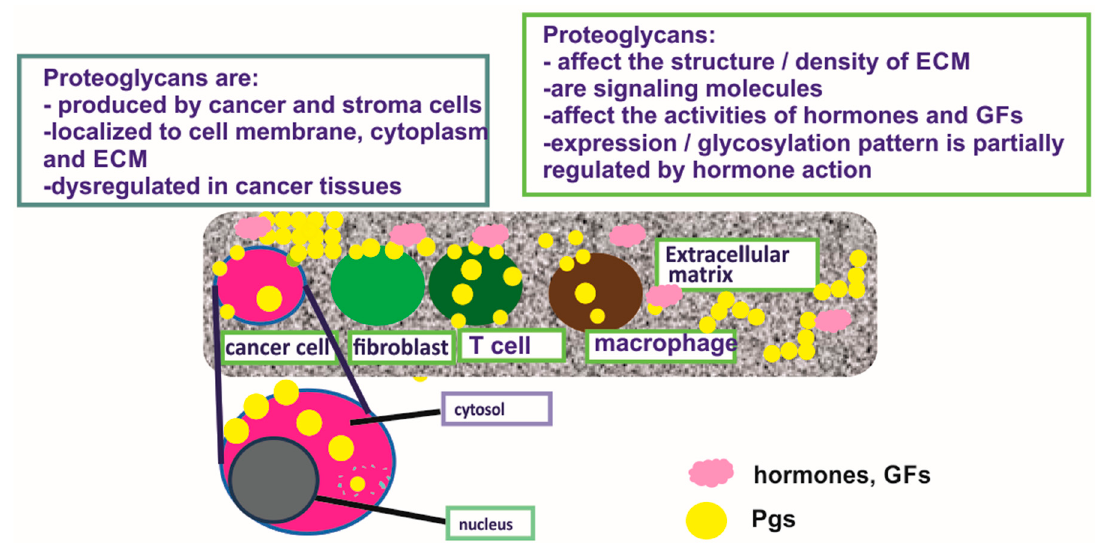
Figure 1. The expression and critical roles of proteoglycans (PGs) in hormone-dependent cancer. PGs are expressed at the cell membrane and cytosol of cancer and stroma cells and secreted to the extracellular matrix (ECM). They contribute to the structure of cancer tissues, e.g., the regulation of tissue density and affect the activities of growth factors and hormones.